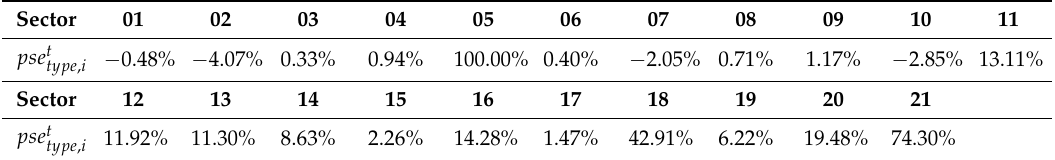
Table 6. The proportion of sector i in its own industry in 2012.